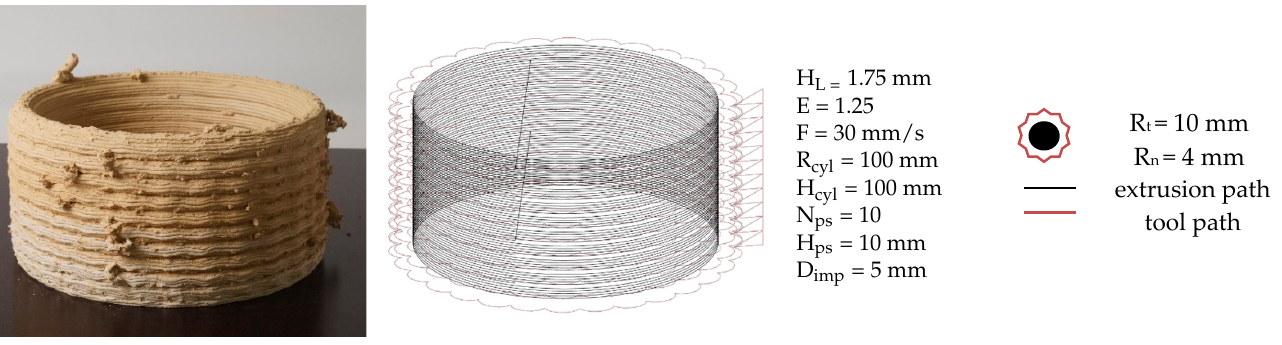
Table 5. Comparison of Grasshopper modelling as complex path instruction (material extrusion + tool) and materialized implementation with stamp tool and round material stencil in the LDM of clay.